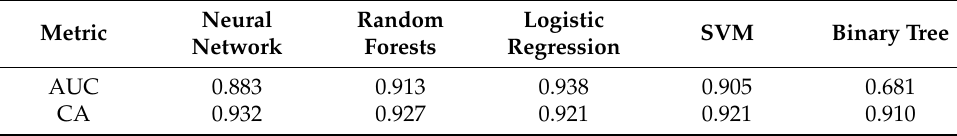
Table 7. Models accuracy metrics for add_to_cart_both as target